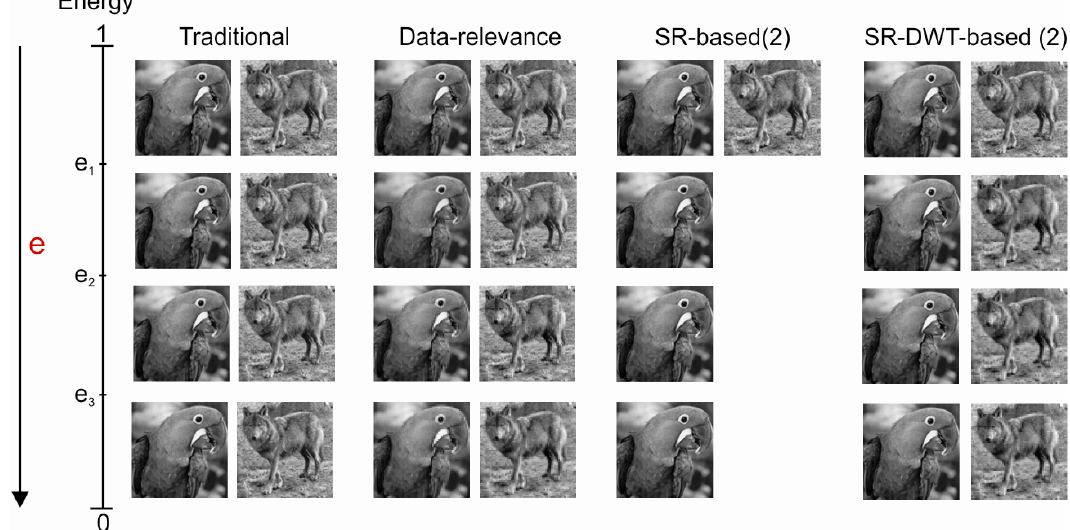
Figure 12. Average quality of the images that reach the sink for different transmission configurations and also considering the SR-DWT-based relaying